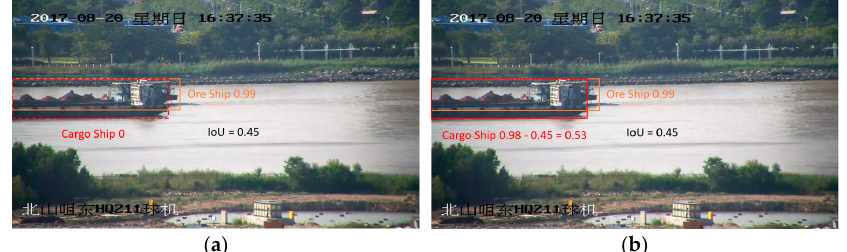
Figure 4. Processing results of overlapping targets by NMS and Soft-NMS; ( a ) NMS processing mode; ( b ) Soft-NMS processing mode.